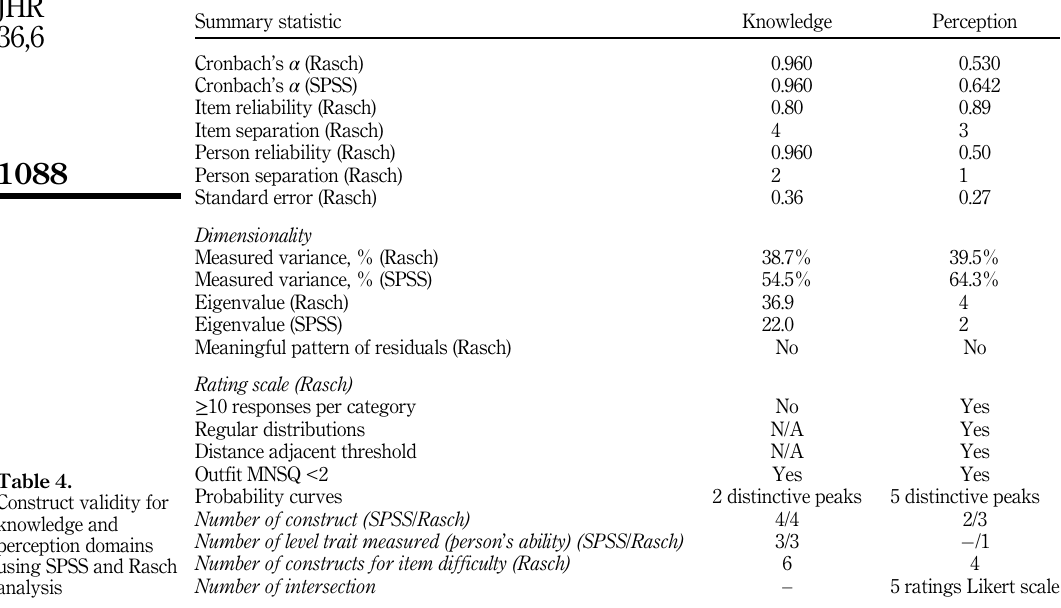
Table 4. Construct validity for knowledge and perception